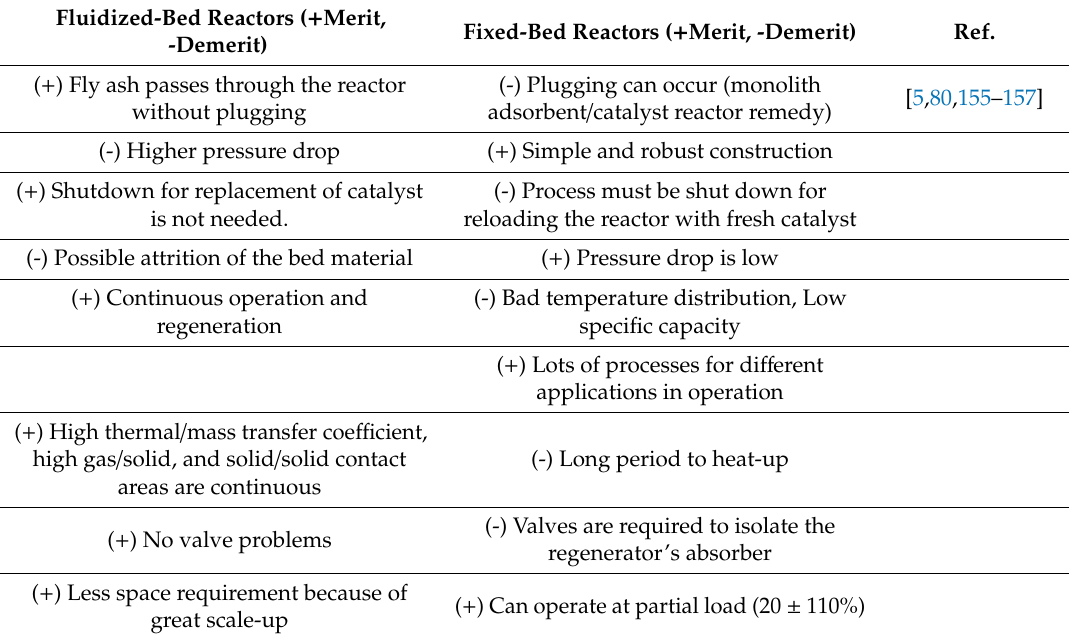
Table 6. Comparison of the fluidized-bed reactors and fixed-bed reactors. Fluidized-Bed Reactors ( + Merit, Fixed-Bed Reactors ( + Merit, -Demerit) -Demerit)